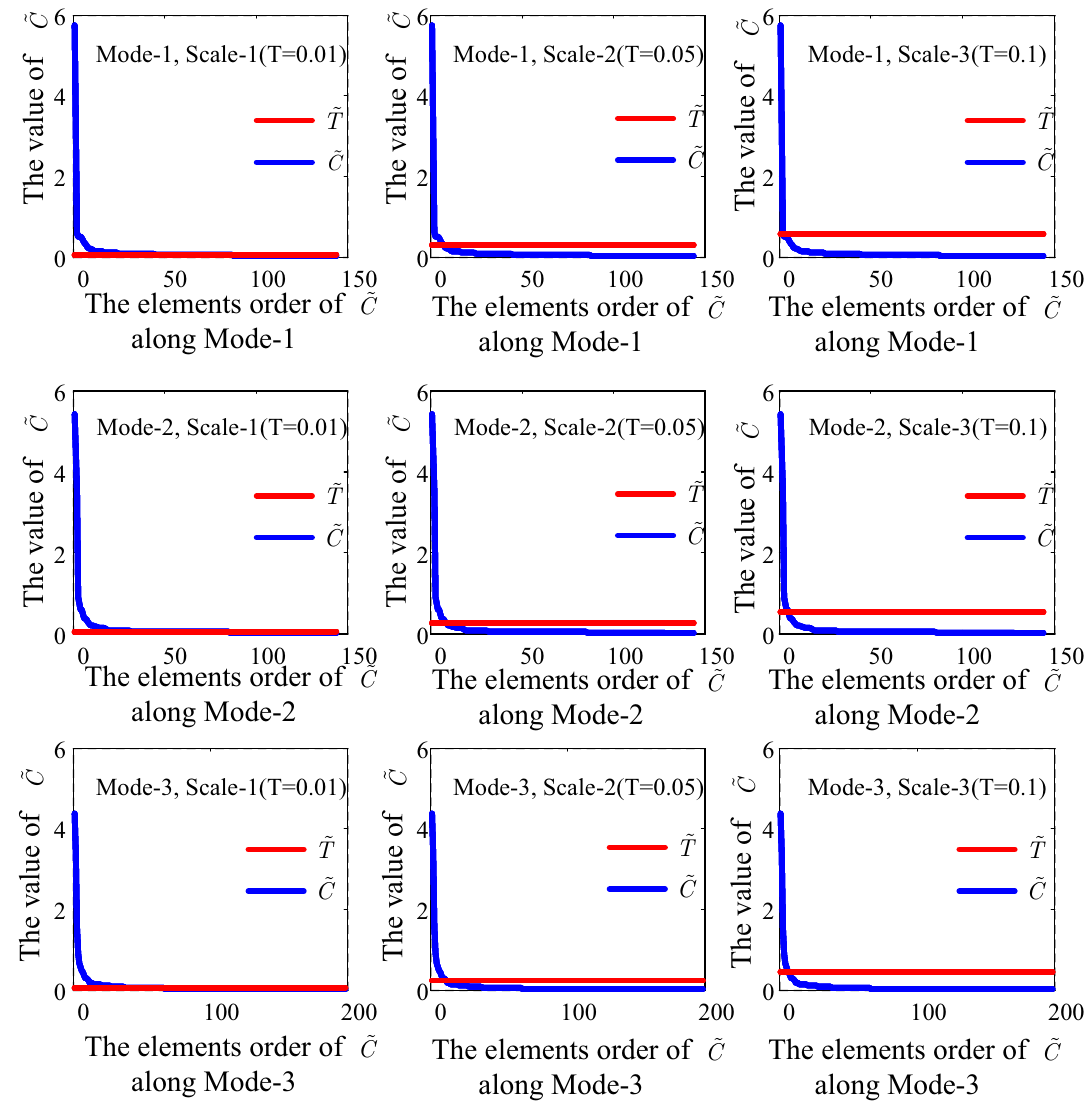
Figure 3. The estimation of optimal multiscale rank along each mode on Indian